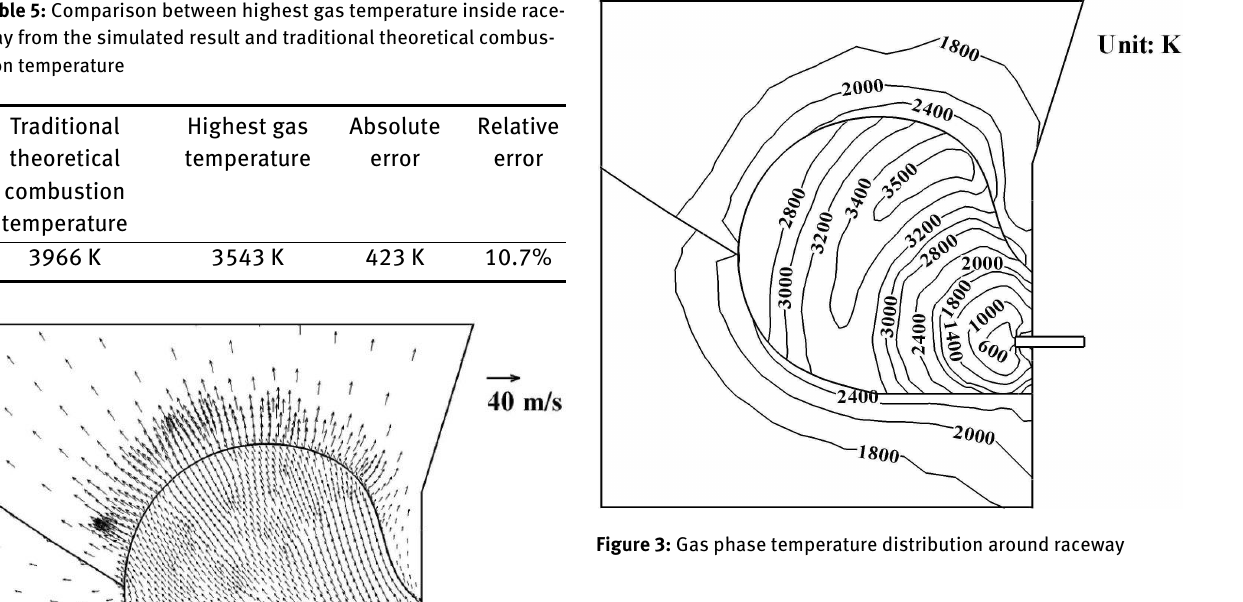
Table 5: Comparison between highest gas temperature inside race- way from the simulated result and traditional theoretical combus-